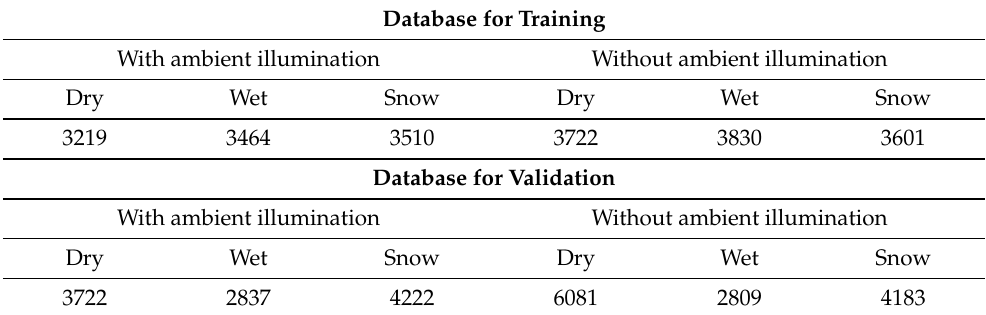
Table 1. Number of images in each class for training and validation under different